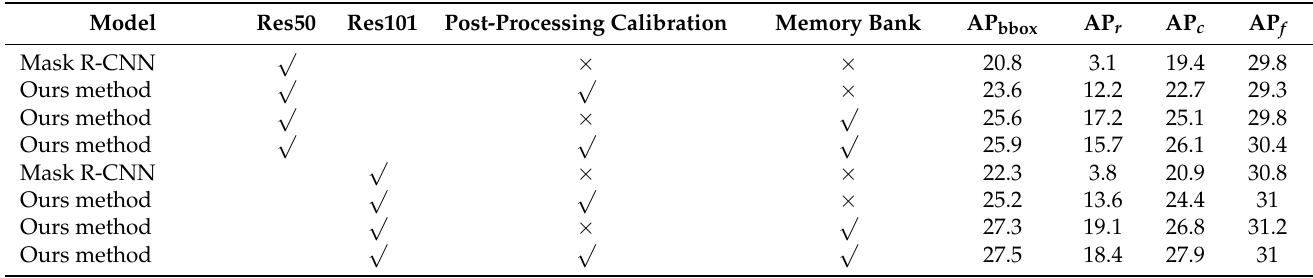
Table 2. Results of ablation